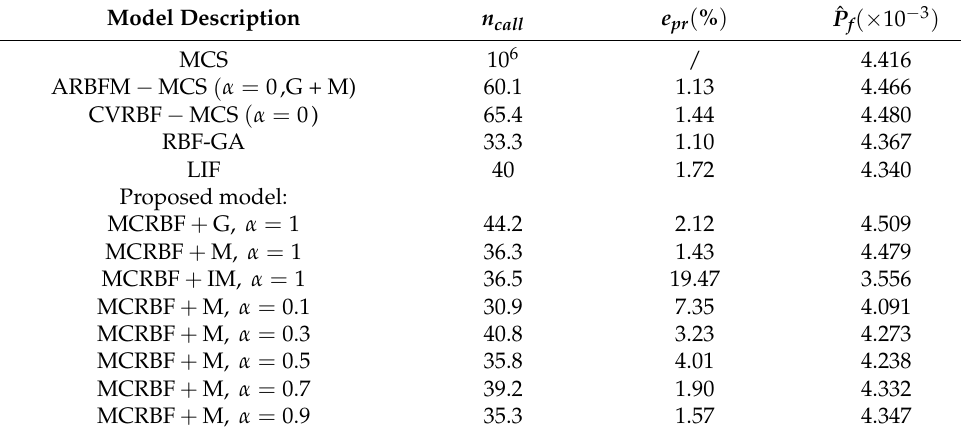
Table 2. The results for example 1.